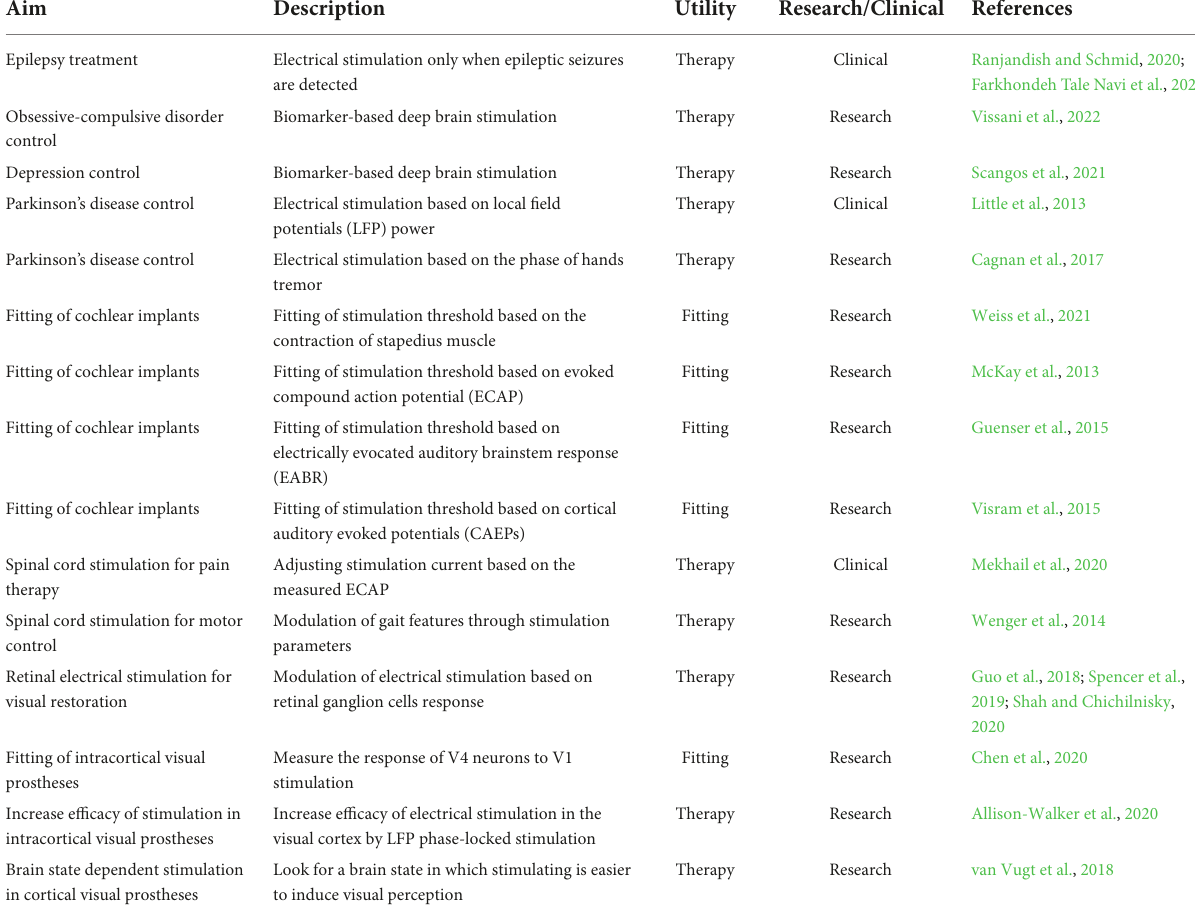
TABLE 1 Examples of closed-loop strategies for neural